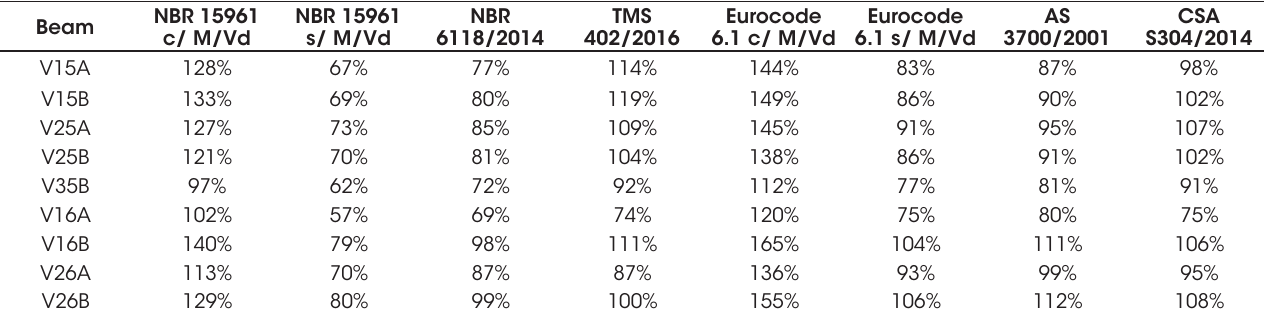
Relation between shear force predicted according to each norm and maximum shear force of each test